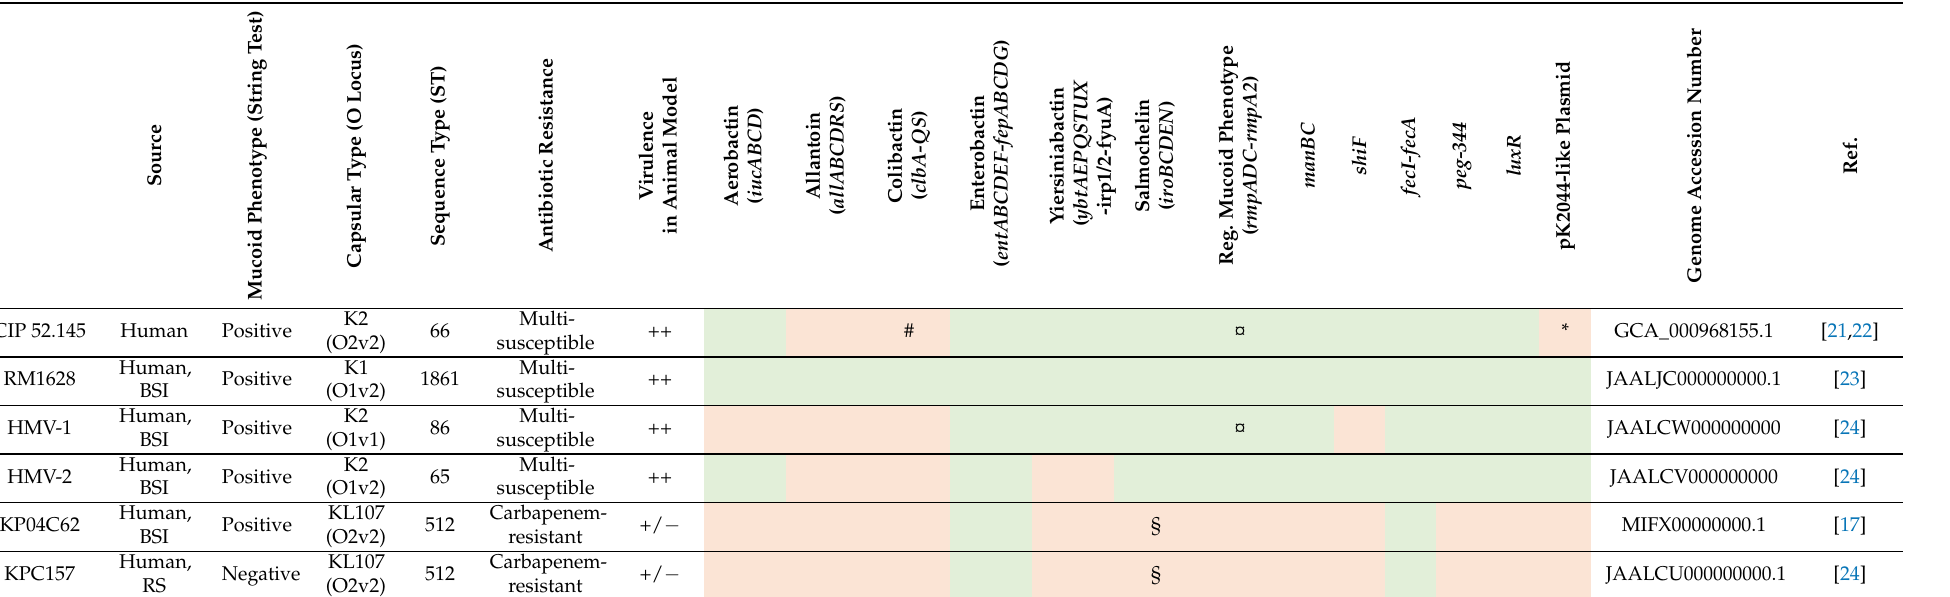
Table 1. Characteristics of Kp strains included in this